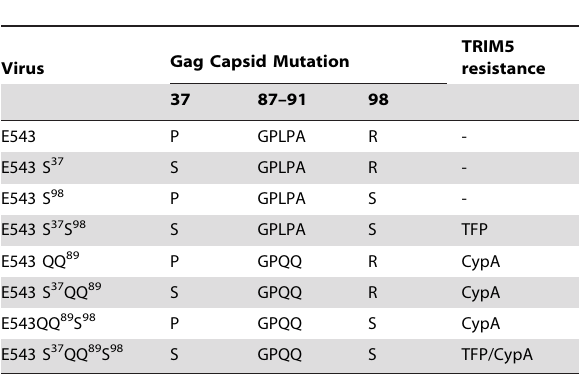
Table 1. Summary of virus mutants and TRIM5